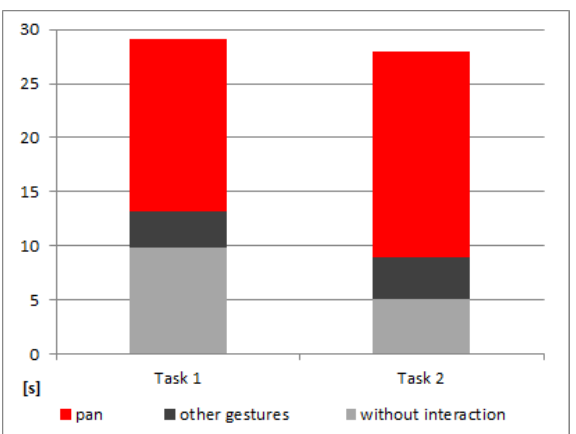
Fig. 4. Average time (in seconds) spent by interaction through